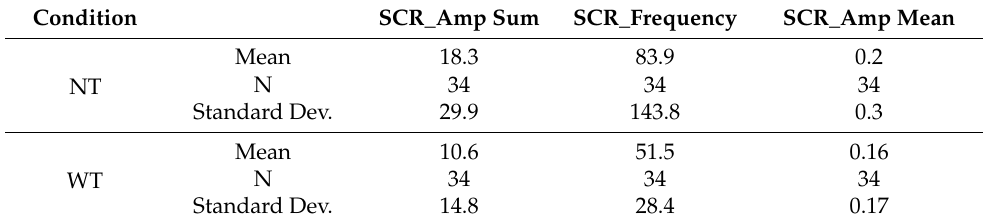
Table 2. Overall SCR Amplitude for NT and WT Conditions.